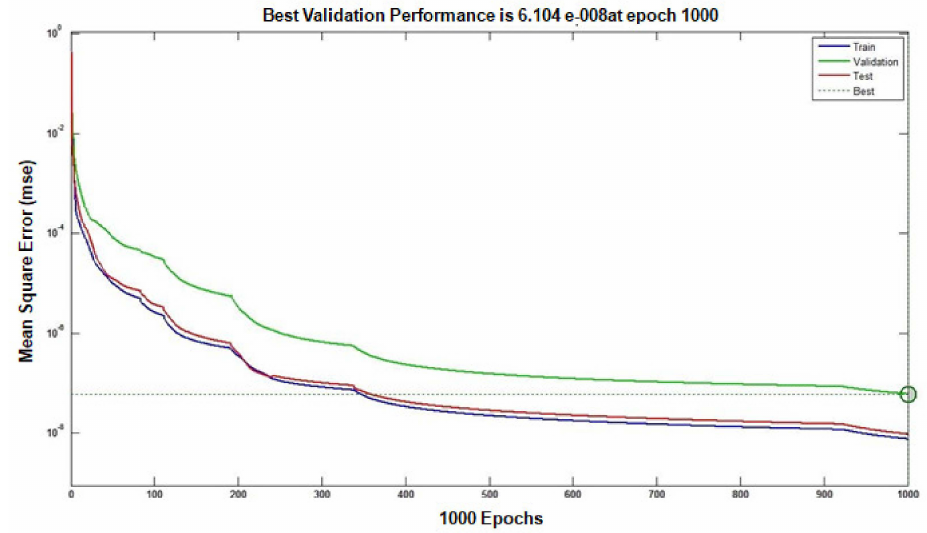
Figure 22. Performance graph of network 4-9-3 for angular distortion between two, three and four